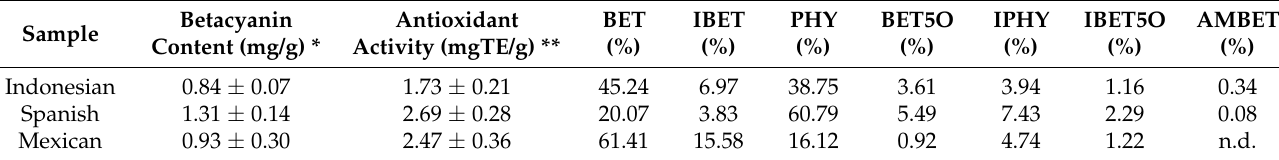
Table 5. Betacyanin total content, antioxidant activity and percentage of each single betacyanin compound in the real samples. Sample